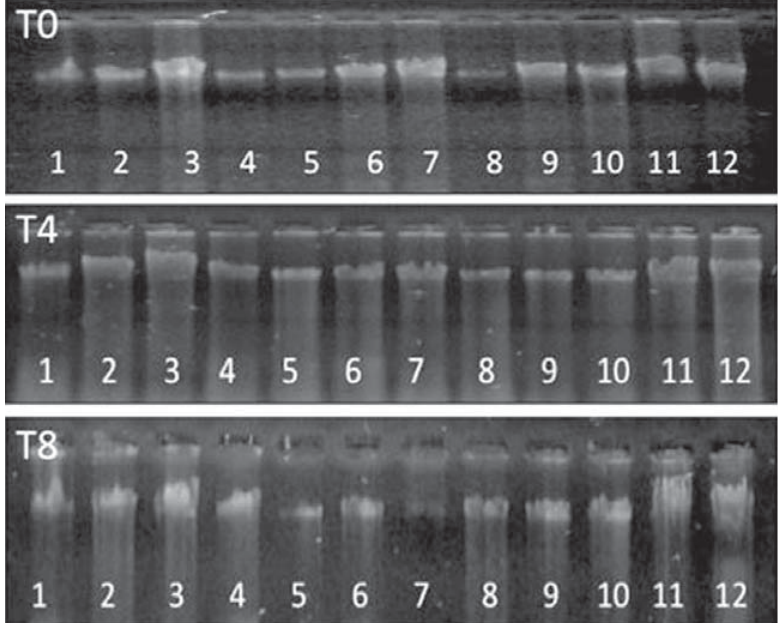
Figure 1- Genomic DNA electrophoresis from DNA obtained from different incubation times (T0, T4 and